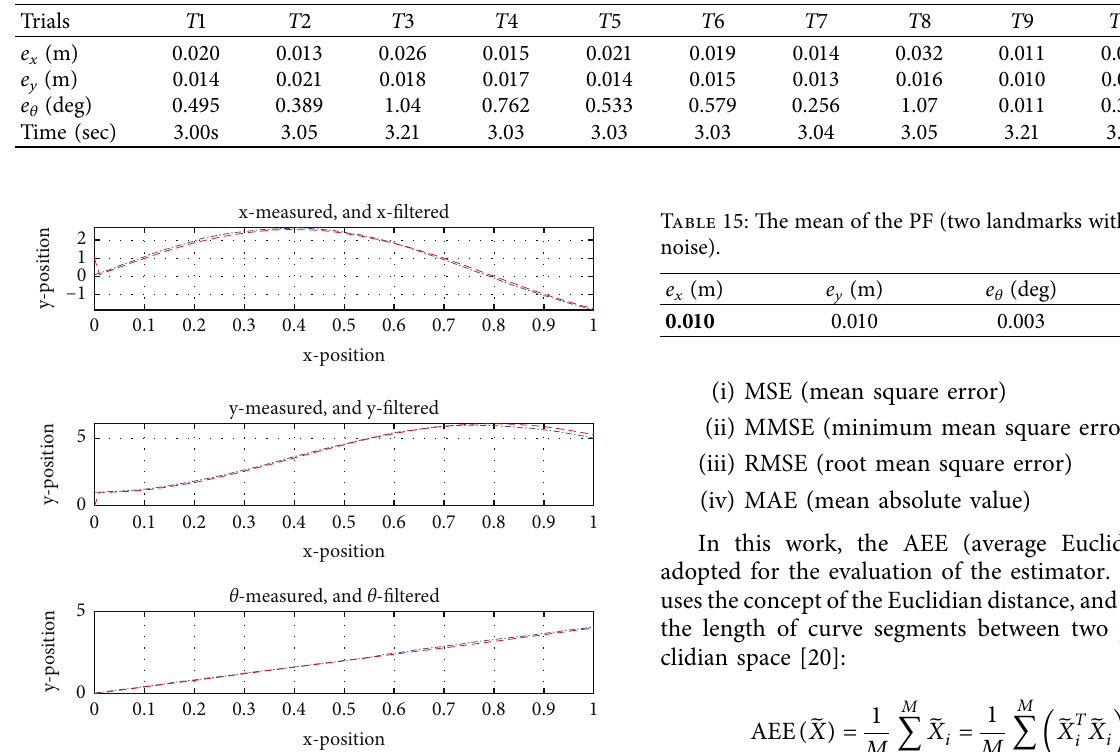
Figure 19: PF performance with two landmarks and non-Gaussian noise.